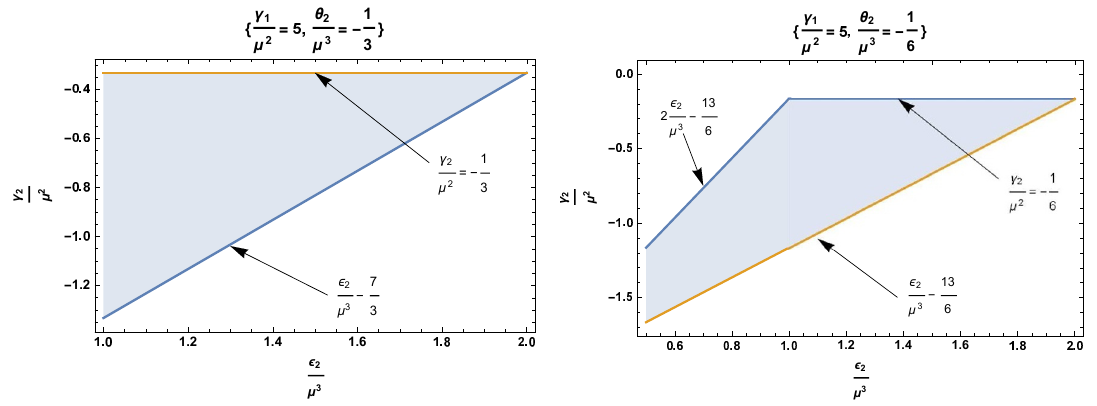
Figure 4 . Phase space of transports ˜ γ 2 and ˜ ǫ 2 . Both of these plots have ˜ γ 2 with the second law of thermodynamics. Functionality of boundaries are derived from Routh- Hurwitz and stability criteria. The area of the left and right plot is 0.5 and 0.875, respectively.